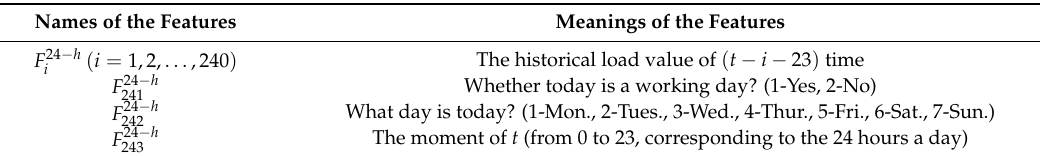
Table 3. The composition of original feature set used for day-ahead prediction.